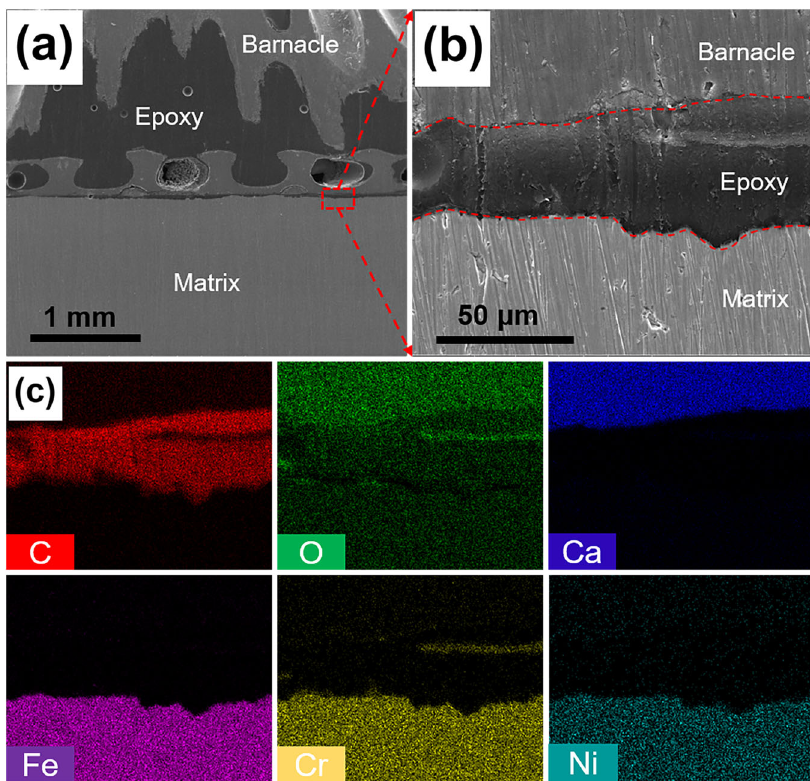
Fig. 11 The SEM and EDS analysis of the interface of barnacle and matrix. a Cross-section morphology, b local magni fi cation, c the main element distribution.